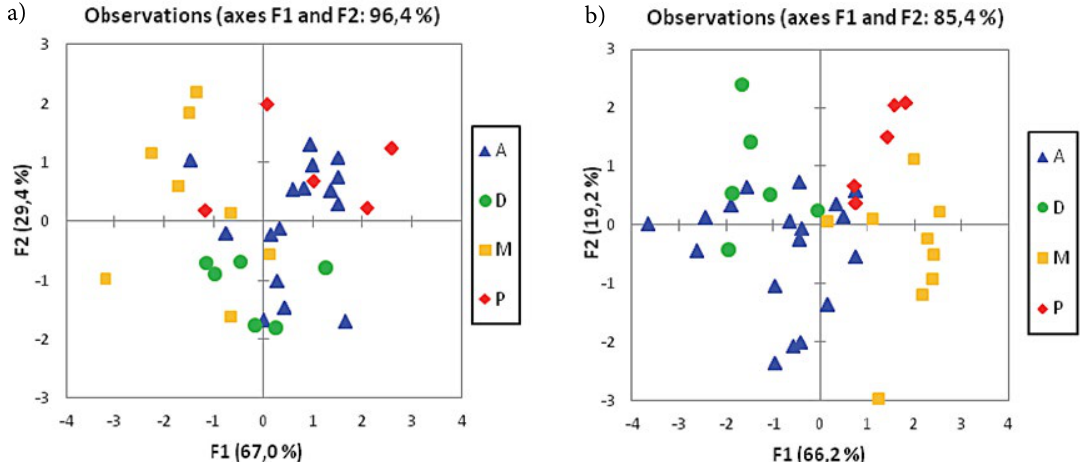
Fig. 4. Discriminant score plots of 38 Slovenian garlic samples from the Alpine (A; n = 18), Dinaric (D; n = 6), Mediterranean (M; n = 9), Pannonian (P; n = 5) regions applying ( a) stable isotope and ( b) elemental